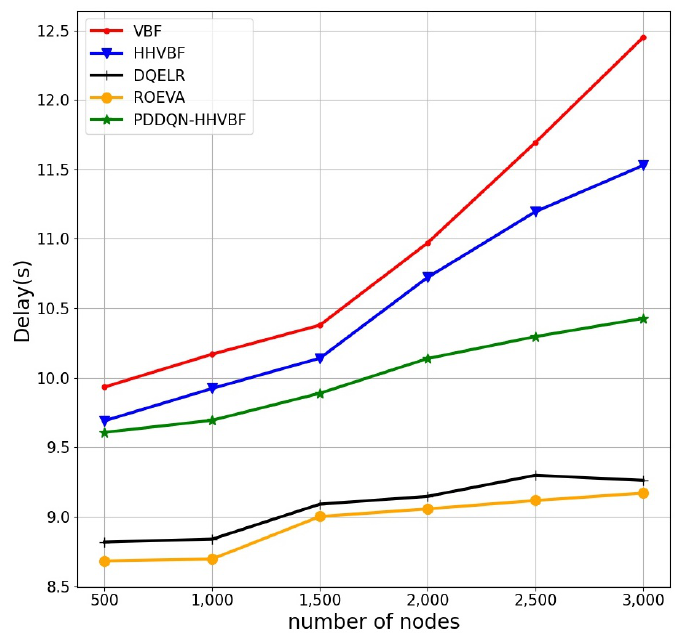
Figure 18. The end-to-end delay of VBF, HHVBF, DQELR, ROEVA, and PDDQN-HHVBF protocol in different number of network nodes.